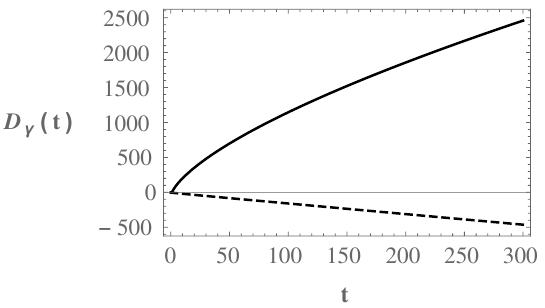
Figure 4. The behavior of the scalar field φ ( t ) and the scale factor a ( t ) against cosmic time for our herein NC model with different values of n . The black, blue and red curves are associated with n = 1, n = 2, and n = 3, respectively. Except n (which varies here), the values for the initial conditions, other parameters and units are equal to the corresponding ones chosen for the Figure 1.